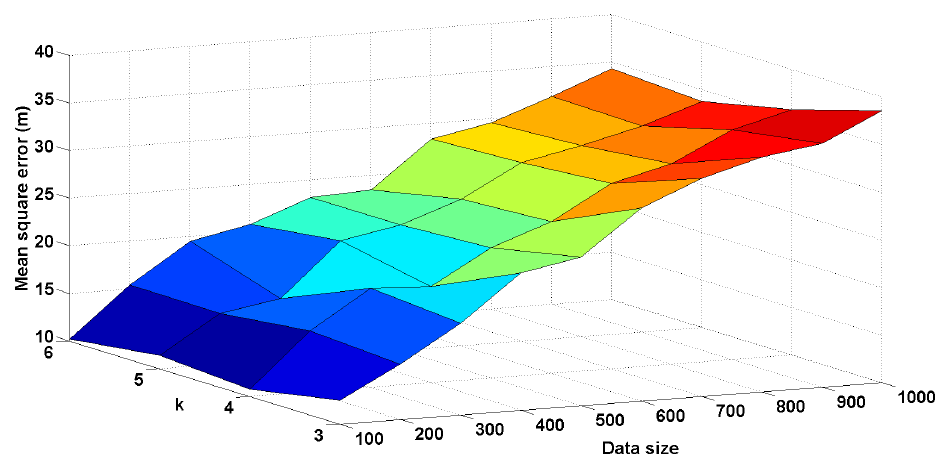
Figure 11. The relation of the error between the number of neighbors and the data